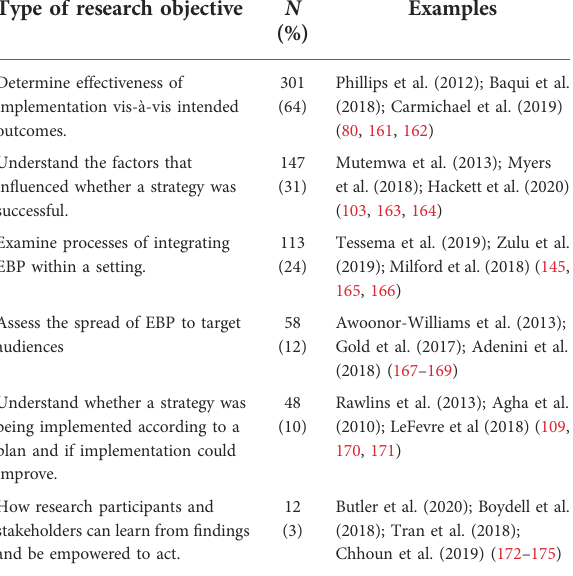
TABLE 3 Classi fi cation of research objectives prioritized in fully reviewed studies ( n =472). Type of research objective